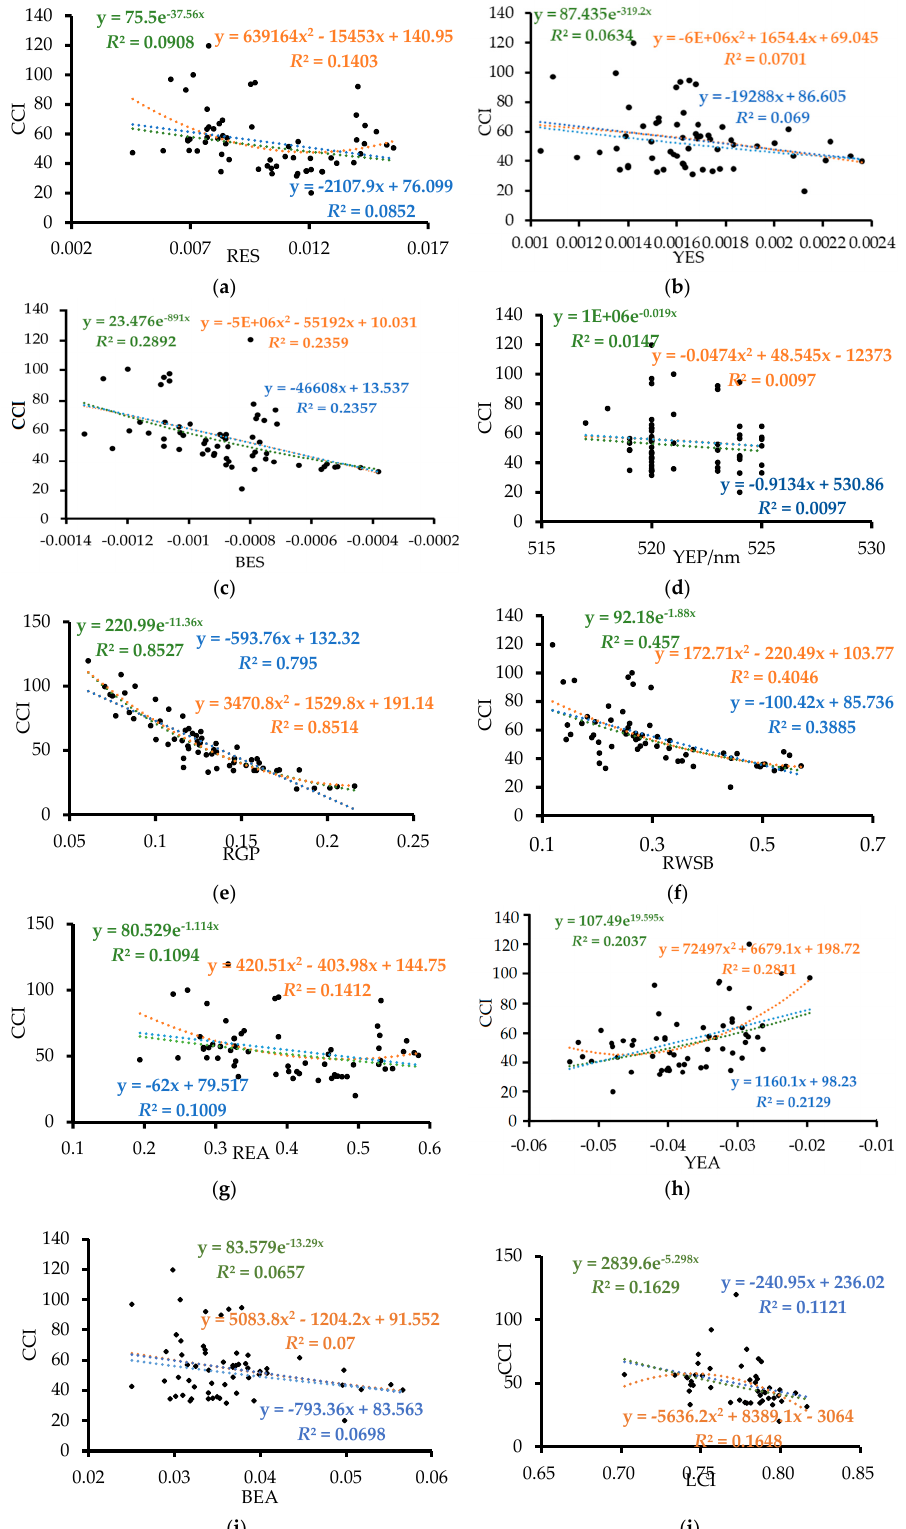
Figure 8. Regression model between chlorophyll content and best spectral parameter. ( a ) RES (red edge slope), ( b ) YES (yellow edge slope), ( c ) BES (blue edge slope), ( d ) YEP (yellow edge position), ( e ) RGP (reflectance of green peak), ( f ) RWSB (reflectance of water stress band), ( g ) REA (red edge area), ( h ) YEA (yellow edge area), ( i ) BEA (blue edge area), ( j ) LCI (leaf chlorophyll index). CCI (chlorophyll content index). Table 3. Regression model of chlorophyll content and spectral parameters (sample number = 60).